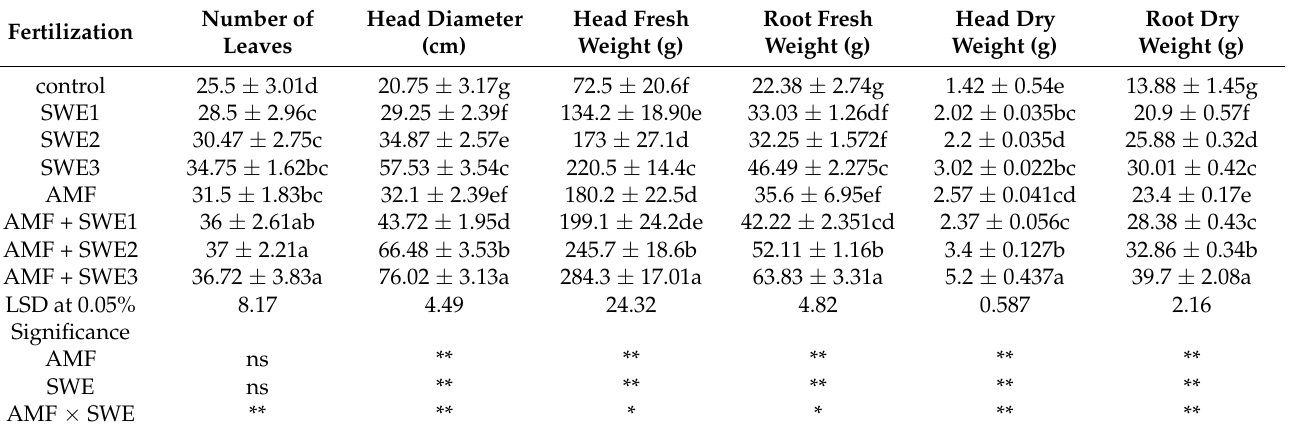
Table 1. The effects of arbuscular mycorrhiza (AMF) inoculation and seaweed (SWE) extract foliar spray on the growth-related traits of lettuce